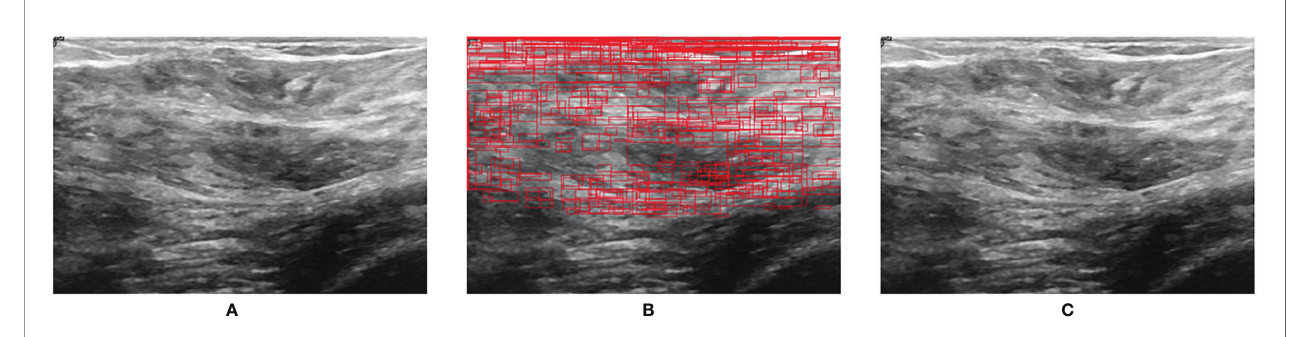
FIGURE 7 | Prediction for a normal US image. (A) Original image. (B) RoIs obtained after selective search. (C)